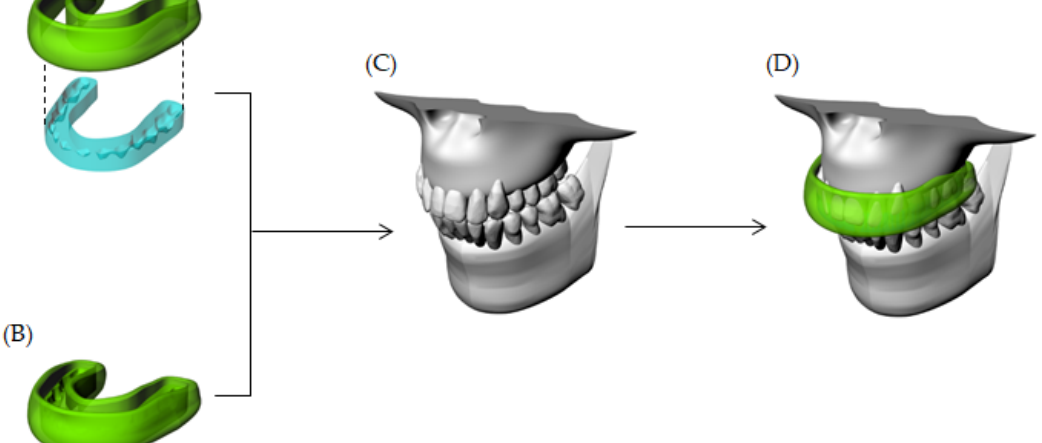
Figure 3. Three-dimensional models simulated in the present study. ( A ) Hybrid occlusal splint- mouthguard (HMG), ( B ) Conventional custom-made mouthguard (MG), ( C ) Maxillofacial structures and, ( D ) Mouthguard in position.